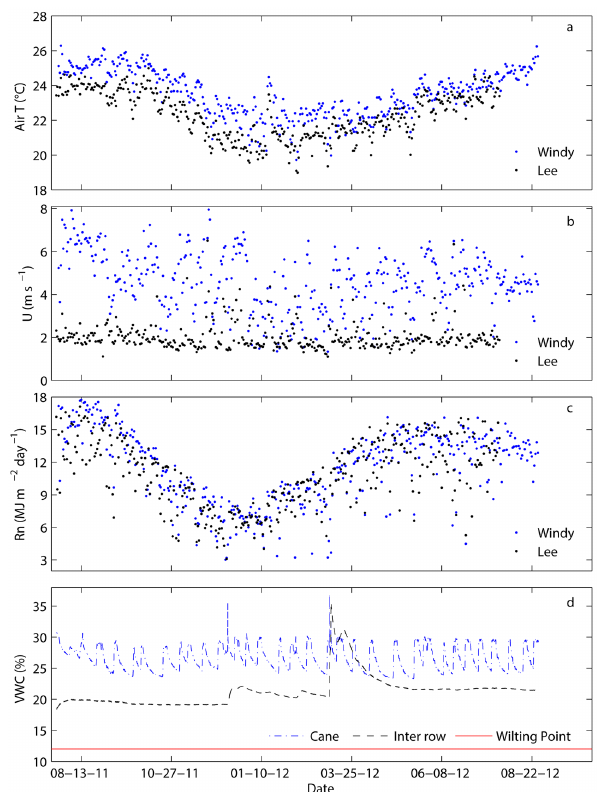
Figure 3. Meteorological and soil observations during the study pe- riod: (a) mean daily air temperature; (b) mean 24h wind velocity; (c) cumulative daily net radiation; and (d) soil volumetric water content (VWC) data from Windy field at 20cm depth underneath cane row (45cm away from drip line) and inter-row or midway be- tween drip lines (137cm away from drip line). Wilting point noted as solid red line (12% VWC).